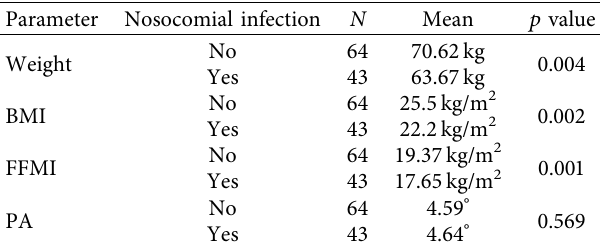
Table 5: Correlation of weight, BMI, FFMI, and PA with noso- comial infection in hospitalized cancer patients.